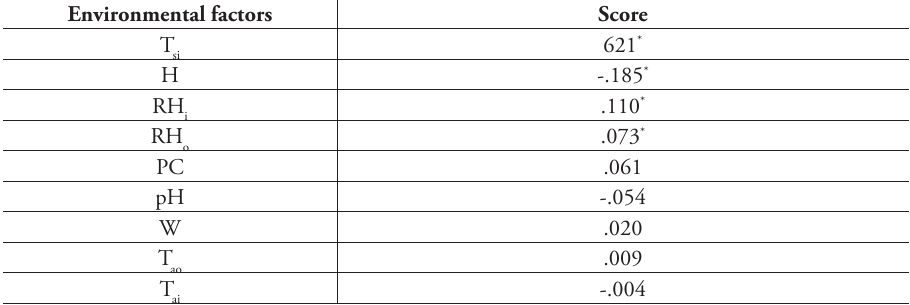
), air temperature outside (T ), relative humidity inside (RH ai ao ), substrate temperature inside (T ), plant cover (PC), and substrate pH. o si